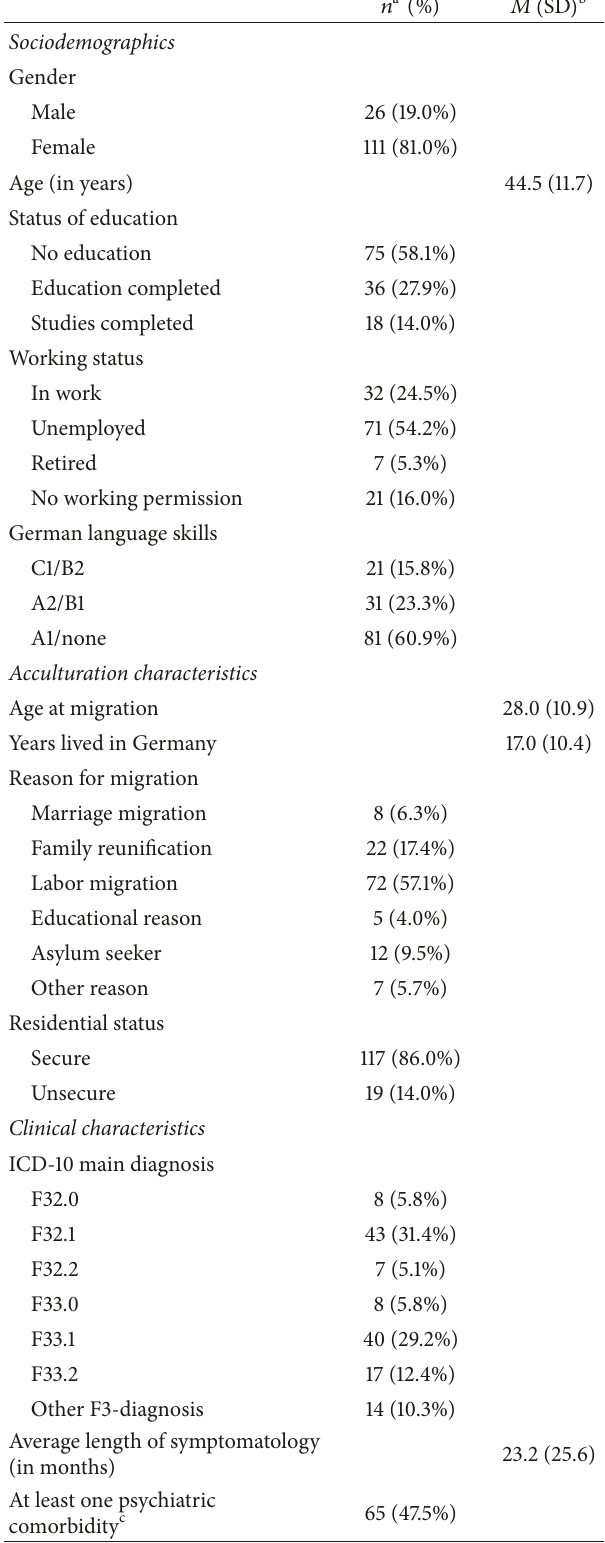
Table 1: Sample characteristics ( 𝑁 = 137